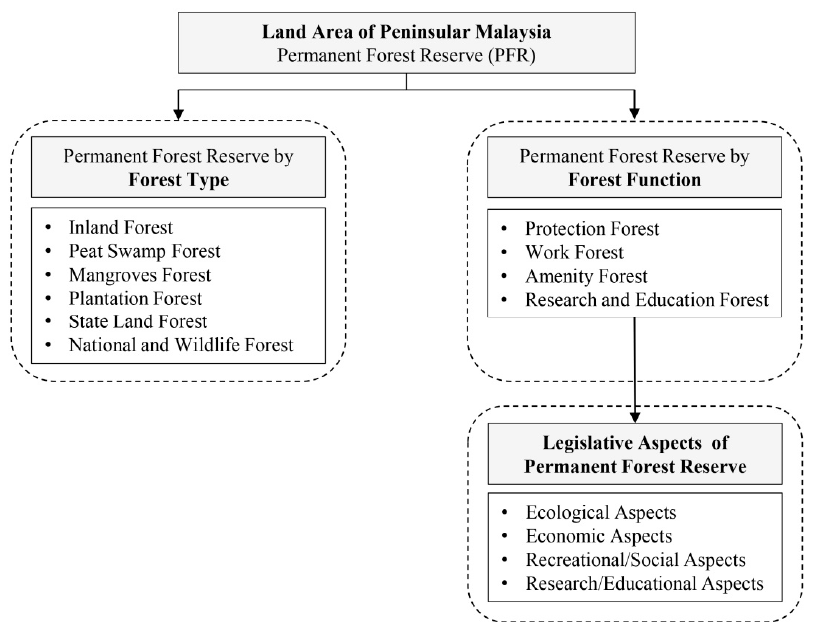
Figure 2. Classification of PFR by forest type, function, and legislative aspect in Peninsular Malaysia.